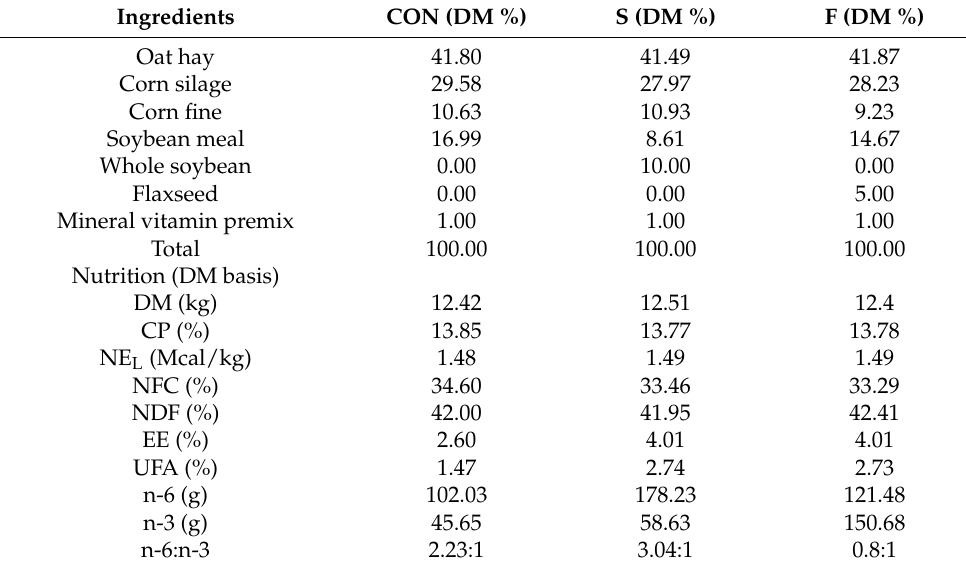
Table 1. Ingredients and chemical composition of the